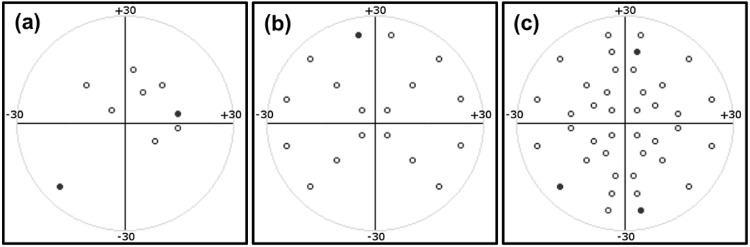
Characteristic examples of both complete (b and c) and incomplete tests (a). White circles indicate a point tested and seen by the subject (positives) and black spots indicate points tested but not seen by the subject (negatives). (a) Test performed before the tiered approach proposed in this paper with 7 points seen yet no standard test pattern being complete. (b) Example of a test terminated before reaching the 20-point pattern yielding a complete 12-point test. (c) Example of complete 40-point test with spurious points identified as unseen by current limits of detection and subsequently rectified through manual investigation.